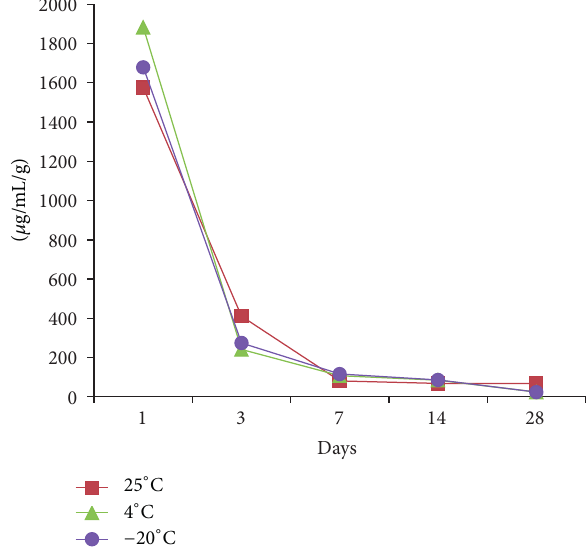
Figure 1: The release of vancomycin fromsamples storedat different temperatures for 2 weeks.